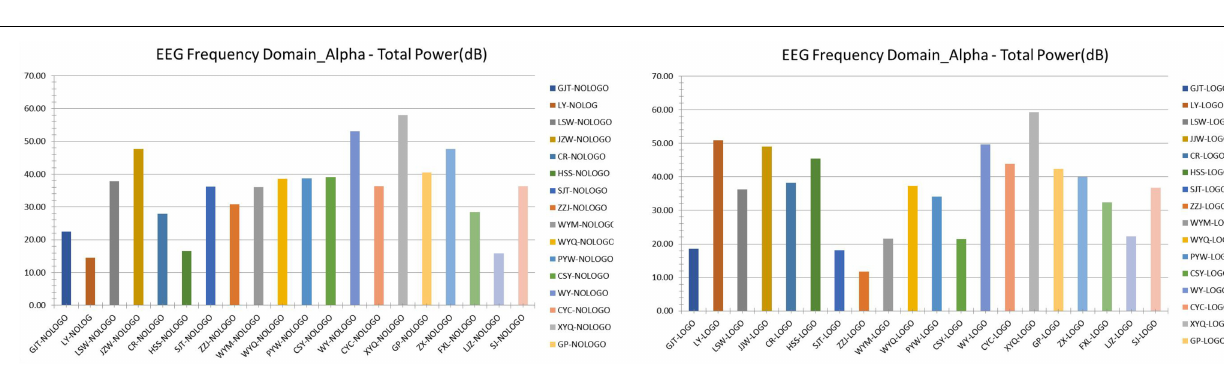
FIGURE 8 | EEG α wave of the testee in scenes A and B-total power (dB) (Search and take screenshots from ErgoLab by our research